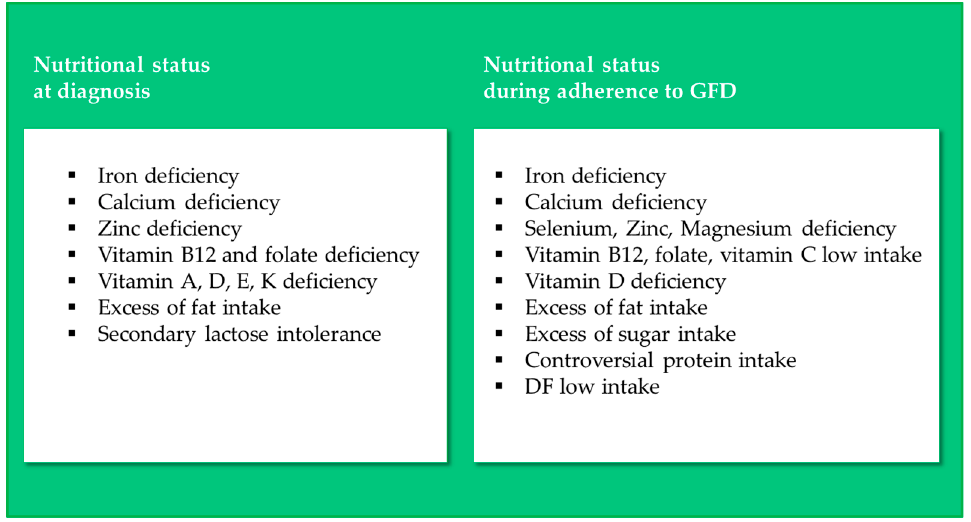
Figure 2. Nutritional inadequacies in CD patients at diagnosis and during adherence to a GFD.